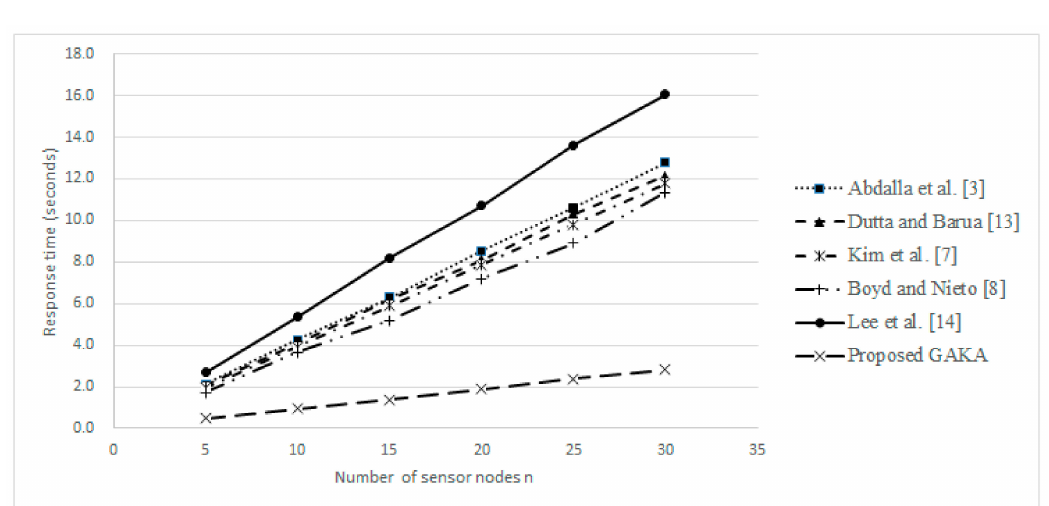
Figure 3. The response time of related protocols and the proposed